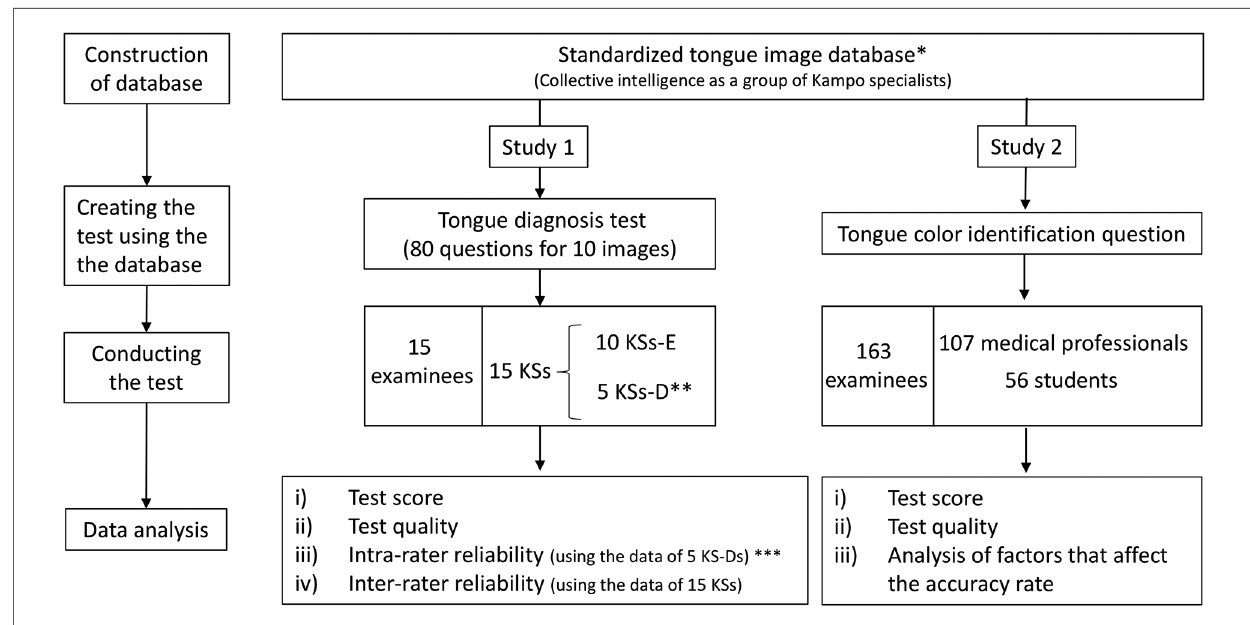
FIGURE 1 Study design. *Five KS-D participants diagnosed 125 tongue images ( fi rst diagnosis). The fi nal diagnosis determined by a majority vote of 5 KS-D participants is linked to the tongue image and constructed database. Details have been reported previously (10). **Five KS-D participants answered the questions of the test (second diagnosis). ***The diagnostic match rate was examined using the data of the fi rst * and second ** diagnoses. KSs, Kampo specialists; KS-D, KS of the database developer group; KS-E, KS of the external evaluator